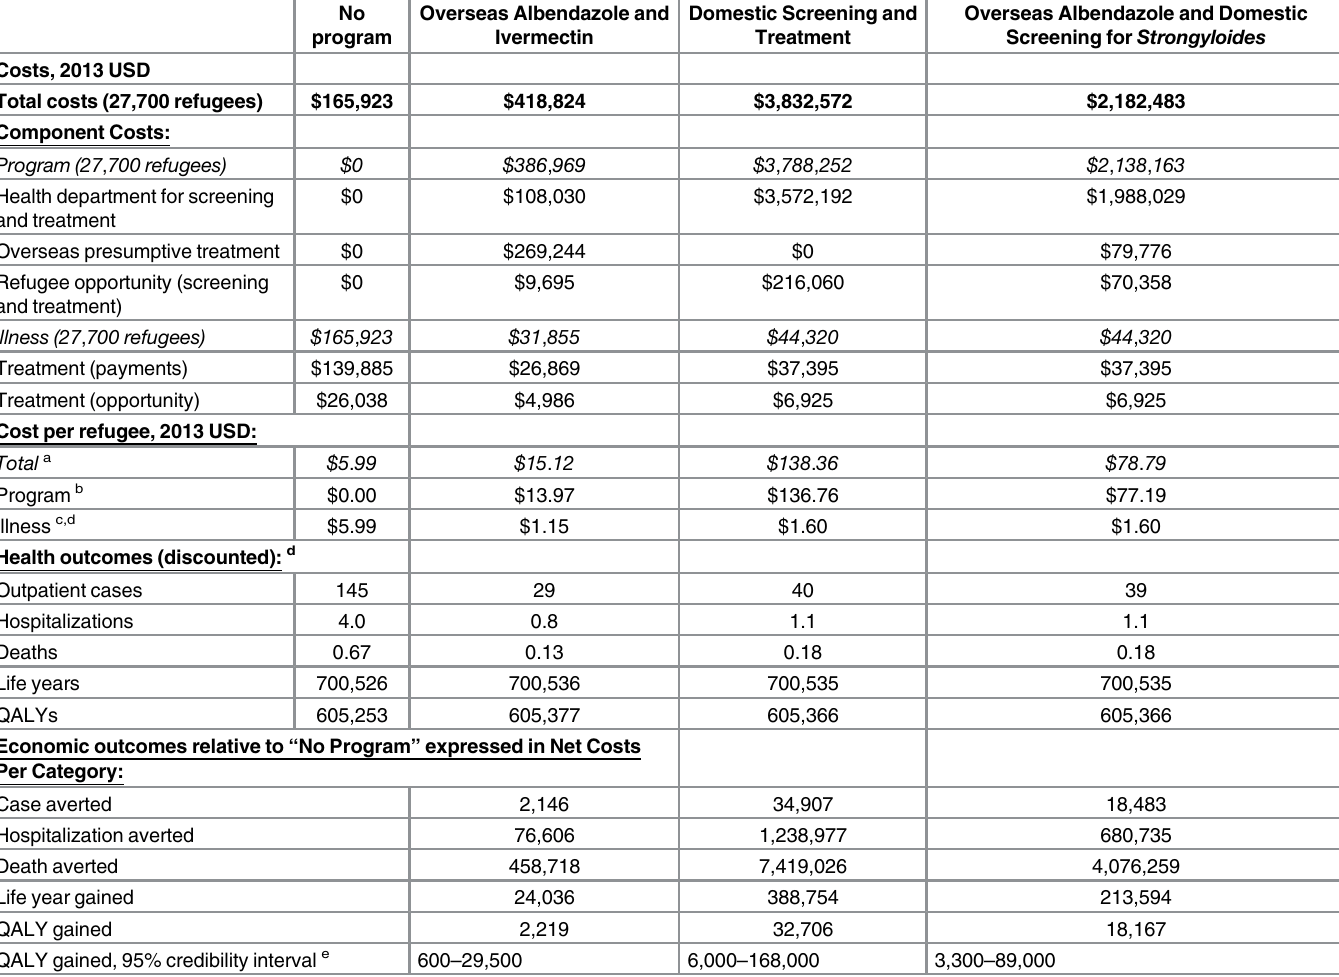
Table 2. Estimated costs and health outcomes for parasite control programs among Asian refugees, 27,700 annual cohort.